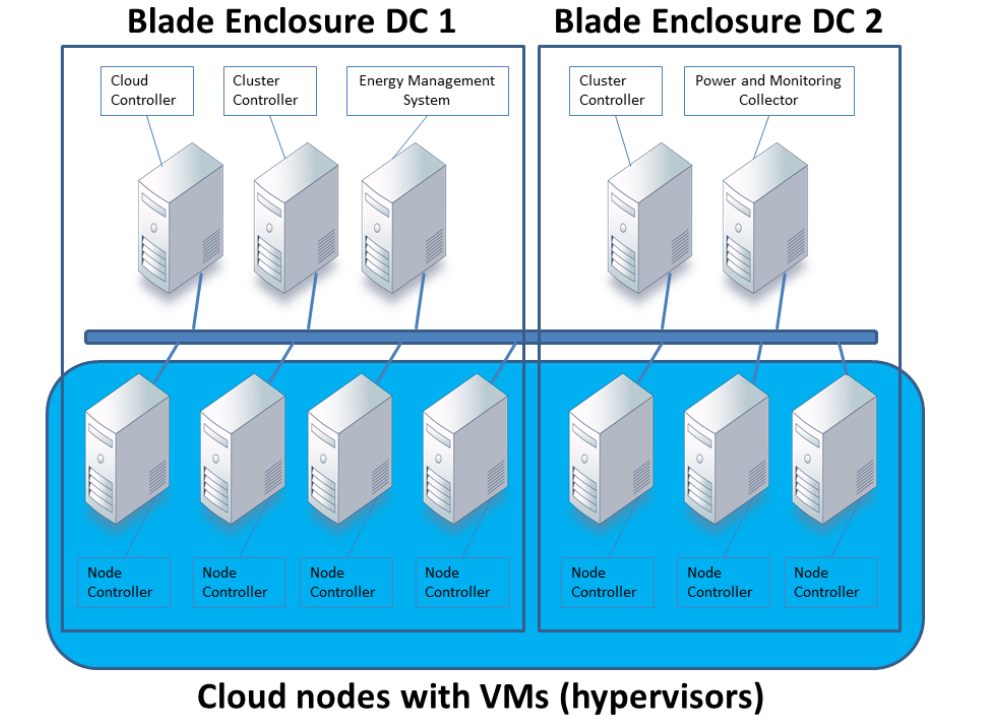
Figure 3. Testbed’s software configuration. Table 1. Testbed’s hardware configuration.